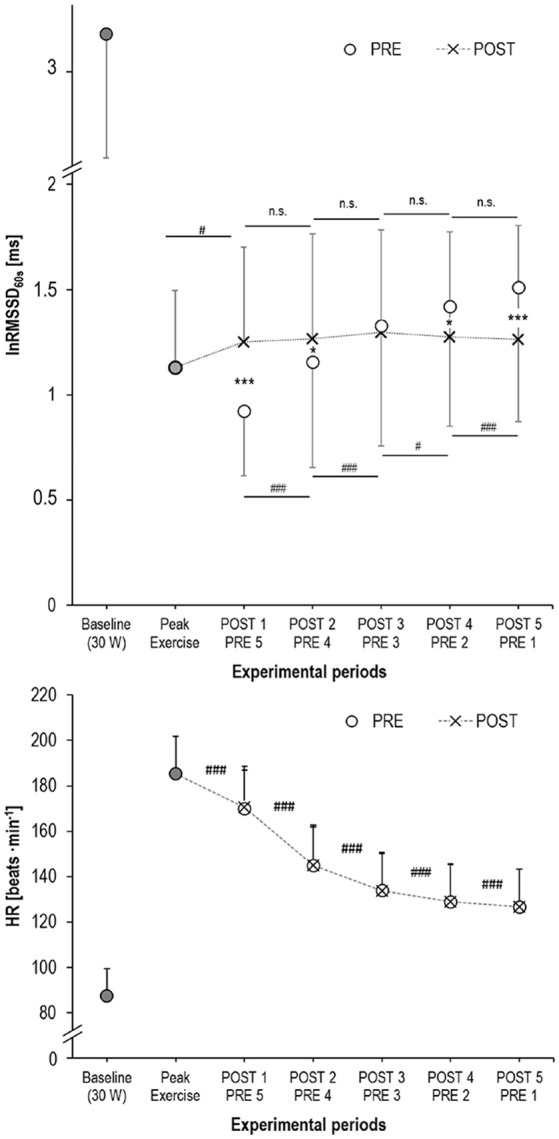
Mean and standard deviation of lnRMSSD60s (upper panel) and HR (lower panel) at baseline (cycling with 30 W, filled circles), at peak exercise (filled circles), during active recovery from exhaustion (POST, crosses) and the HR-matched segments during cycling before exhaustion (PRE, open circles); significance of the lnRMSSD60s-differences: ***p < 0.001, *p < 0.050 between PRE vs. POST; ###p < 0.001, #p < 0.050 between adjacent measurement time points.